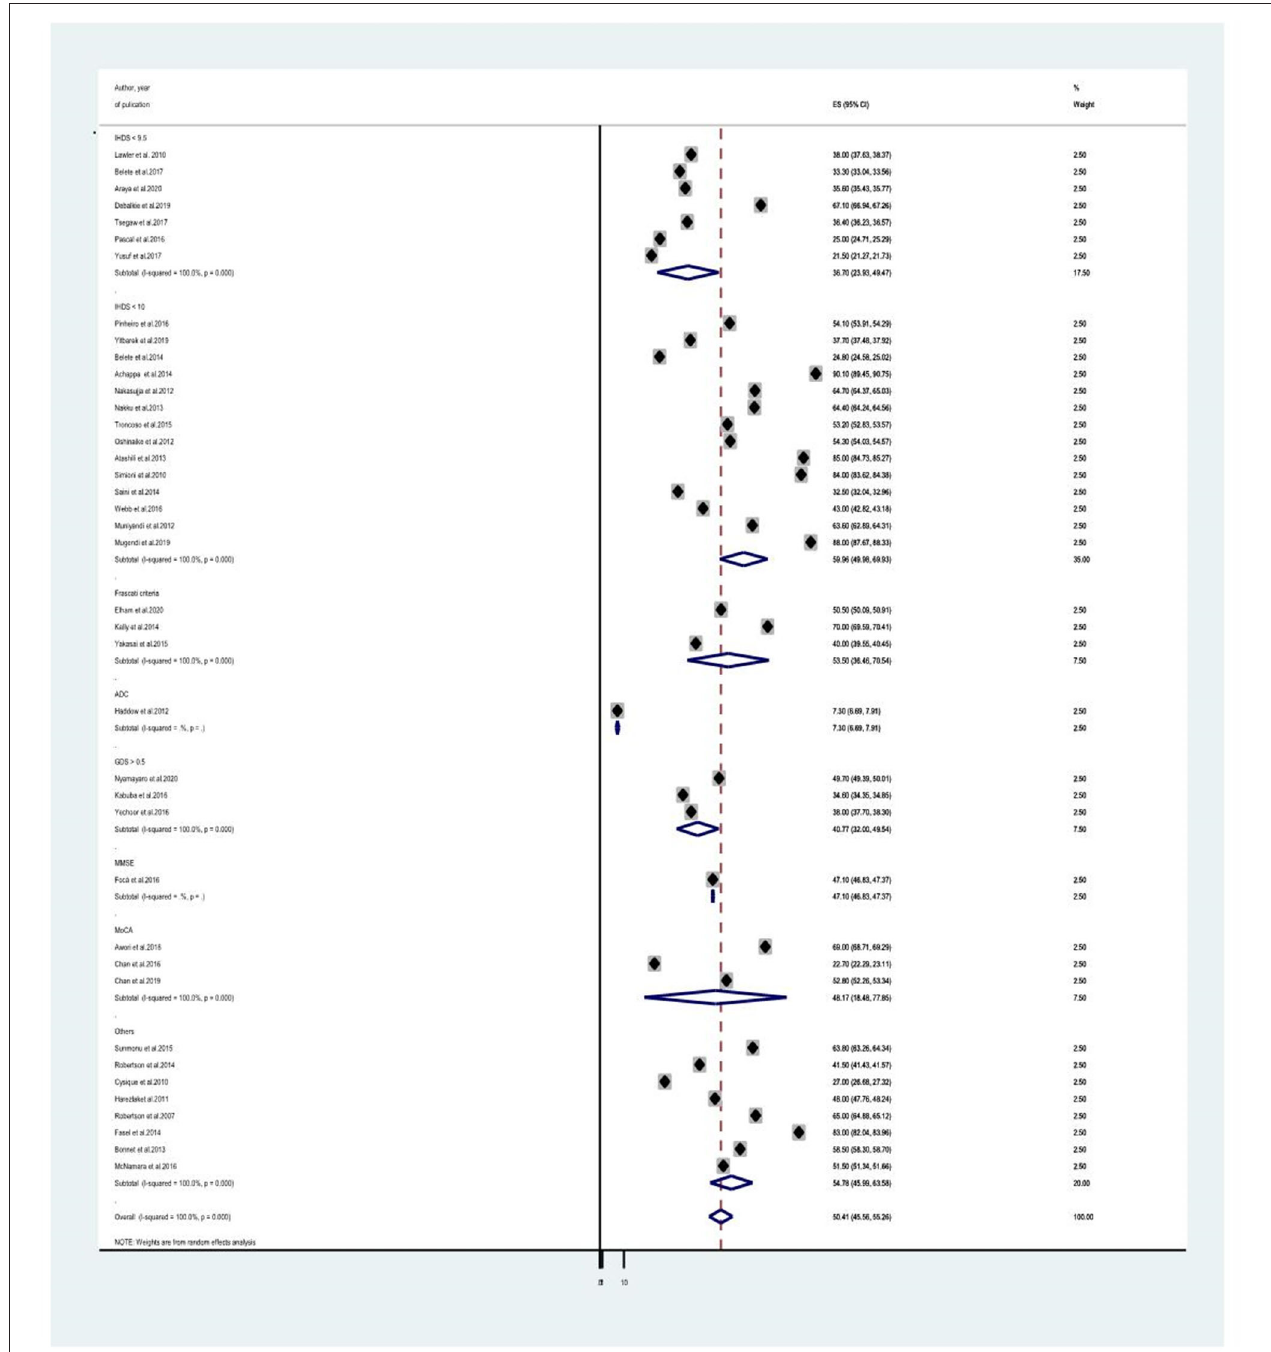
FIGURE 4 | A subgroup analysis for the prevalence of HIV associated neurocognitive disorders based on study tools.